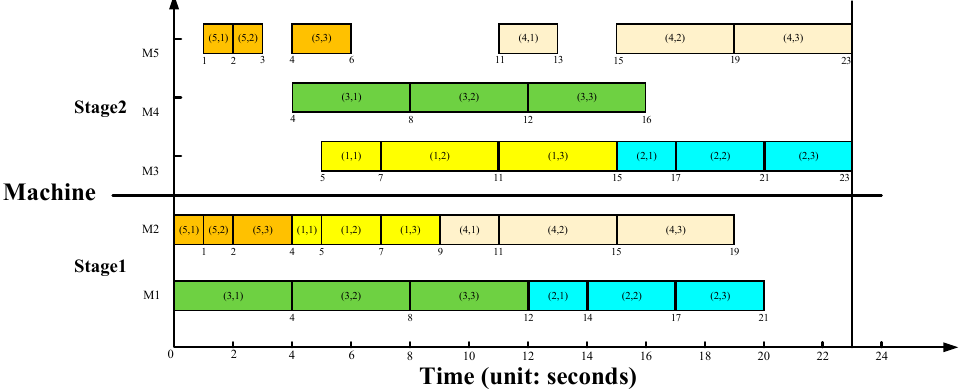
Figure 2. The schedule Gantt chart for the illustrative example.